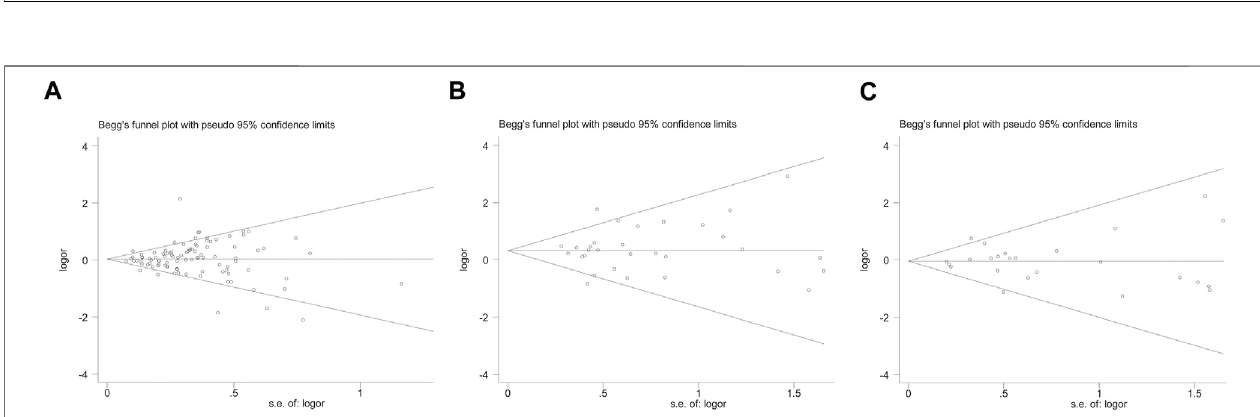
FIGURE7| Begg ’ sfunnelplottoassesspublication biasonthecombinedeffectsof TP53 polymorphismswithBCriskinoverallpopulation(GGvs.CC +CG)[ (A) : codon 72 polymorphism; (B) : IVS3 16 bp polymorphism; (C) : IVS6+62A > G polymorphism].